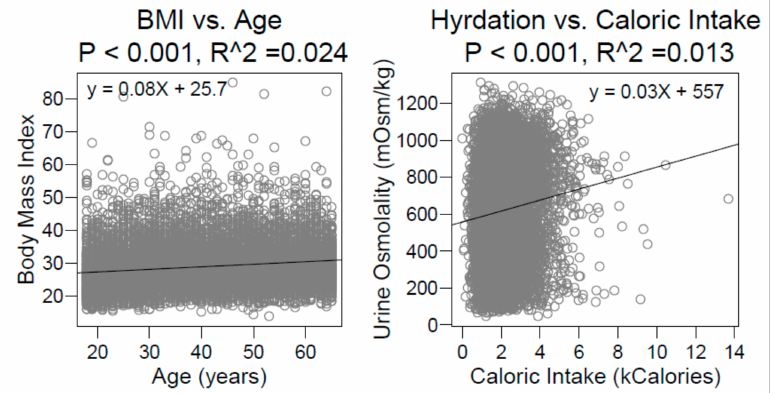
Figure 1. Univariate regressions from the National Health and Nutrition Examination Survey (NHANES) 2009–2010 and 2011–2012 datasets, based on Chang et al. ( Left ) and Rosinger et al. ( Right ). Both regressions have highly significant p -values but negligible R 2